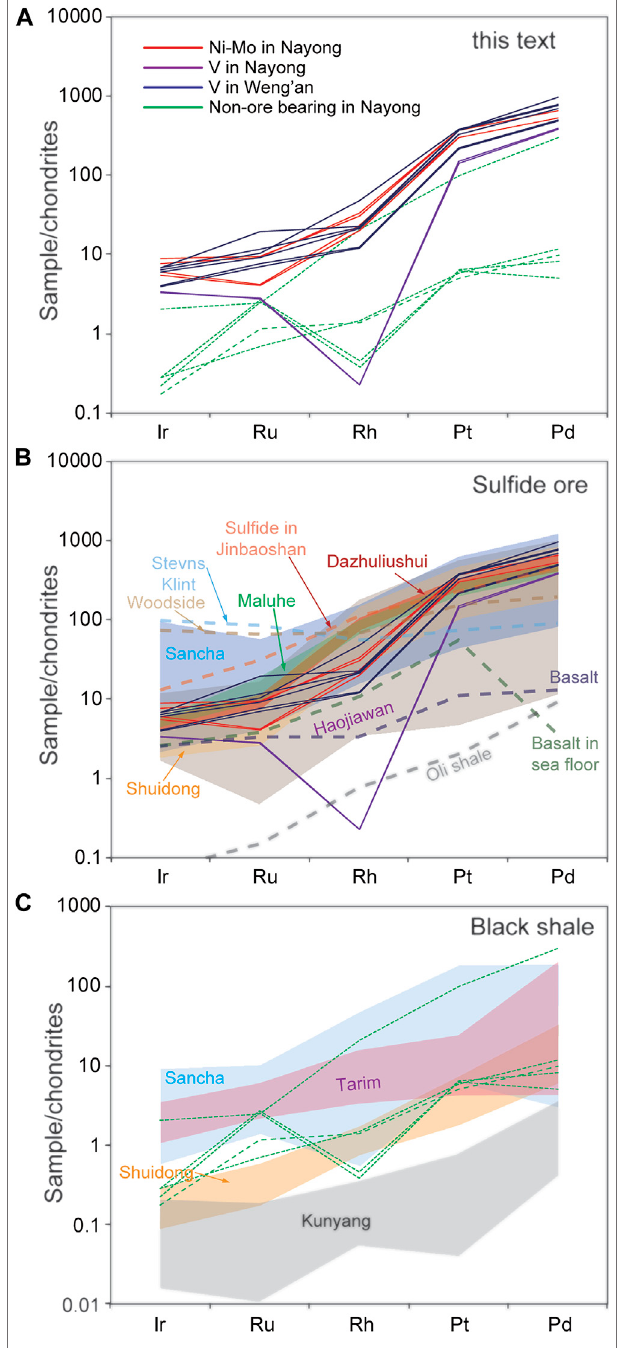
FIGURE 6 | PGE/chondrite distribution pattern of the Cambrian ore- bearing layer and black shale. Chondrite data are from McDonough and Sun (1995); Jinbaoshan basic-rock sul fi de-enclave data are from Wang et al. (2010); ocean- fl oor basalt data are from Sun et al. (2010); K – T boundary layer clay data are from Evans et al. (1993); oil shale data are from Fu et al. (2010); other data are from Wu et al. (2001), Li and Gao (2000), Mao et al. (2001), Wu et al. (2001), Xu et al. (2013), Xing et al. (2015), and Han et al. (2015).